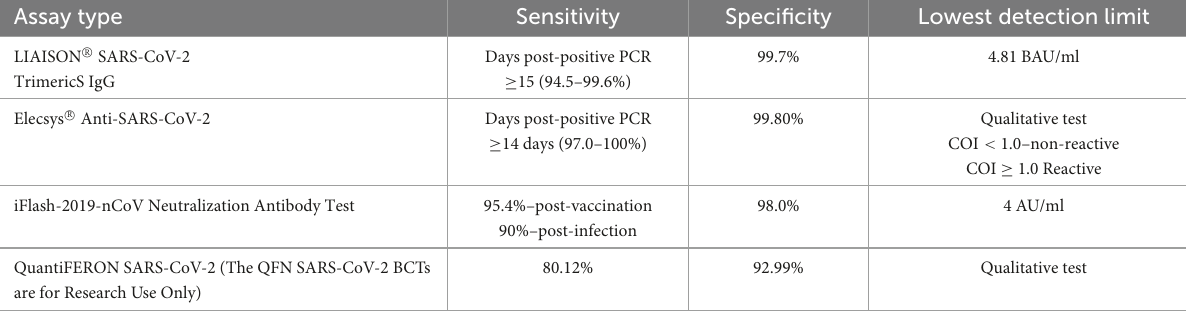
TABLE 1 Sensitivity, specificity, and the lowest detection limit for the used laboratory assays. Assay